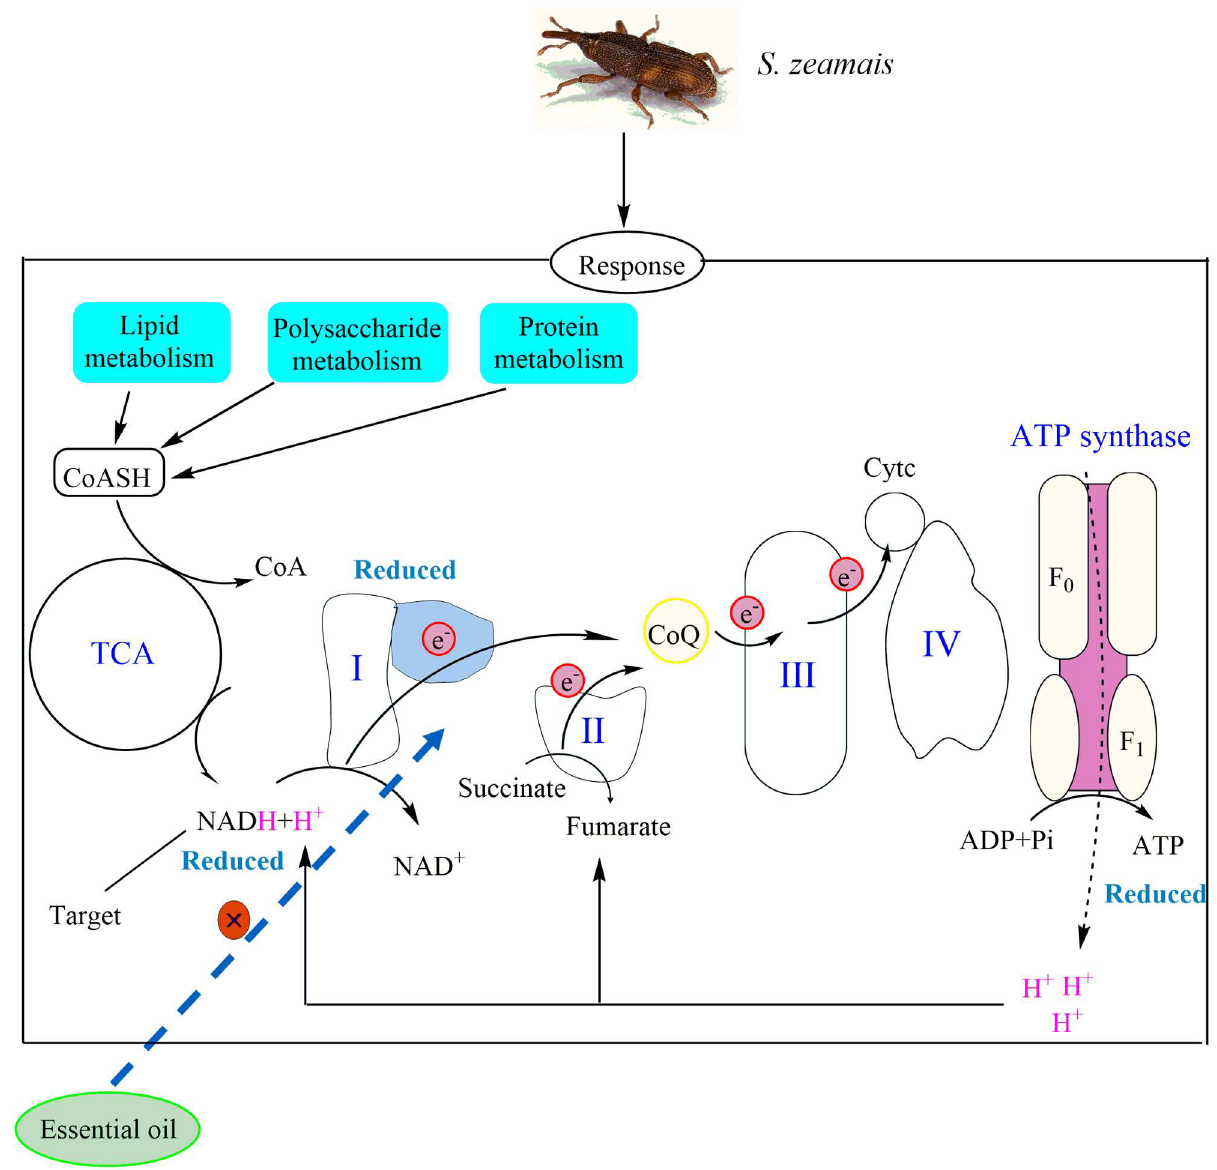
Fig 5. Overview of aerobic respiration and energy synthesis in the mitochondrial respiratory chain upon essential oil exposure. The complex I is a target-recognizing domain.The blue dotted arrowed line representsthat essentialoil affects the hydrogen carrier to block the electron flow. The genesencodingcomplexII-IV were down-regulated. The genesencodingtricarboxylic acid cycle (TCA), lipid, polysaccharide, and protein metabolismwere up-regulated at different expressionlevels. CoASH, CoA, NADH, NAD + , CoQ, Cytc, ATP, ADP, Pi, H + , and e - represent the hydrogensulfide coenzyme A, coenzyme A, nicotinamide adeninedinucleotide,nicotinamide, coenzyme Q, cytochrome C, adenosine triphosphate,adenosine diphosphate, phosphonates, hydrogenion, and electron,